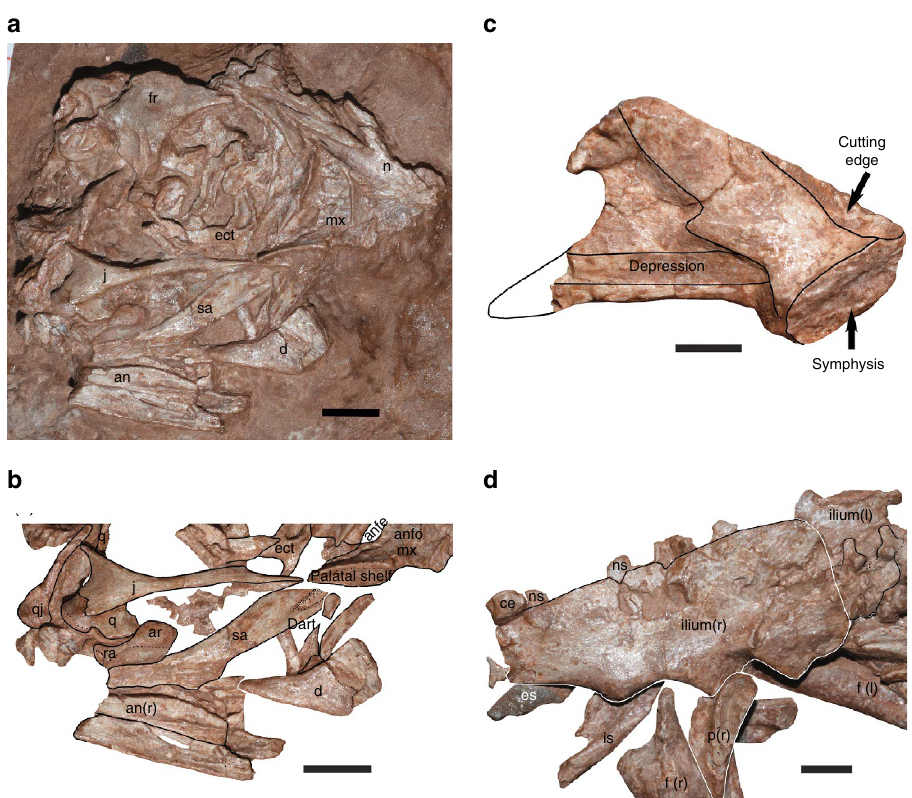
Figure 3 | Photographs of Beibeilong sinensis (HGM 41HIII1219). ( a ) Skull as preserved on right side. Scale bar, 1cm. ( b ) Bones identified in lower part of skull and mandibles from ( a ). Scale bar is 15mm. ( c ) Left dentary in medial view. Posteroventral process restored from the partial right dentary. Scale bar is 5mm. ( d ) Pelvic region in right lateral view. Ilium shows juvenile bone texture, and association with sacral spines and last few dorsals. Scale bar, 1cm. an, angular; anfe, antorbital fenestra; anfo, antorbital fossa; ar, articular; ce, centrum; d, dentary; dart, dentary articulation; ect, ectopterygoid; es, eggshell; f, femur; fr, frontal; is, ischium; j, jugal; max, maxilla; n, nasal; ns, neural spine; p, pubis; q, quadrate; qj, quadratojugal; ra, retroarticular process; sa,